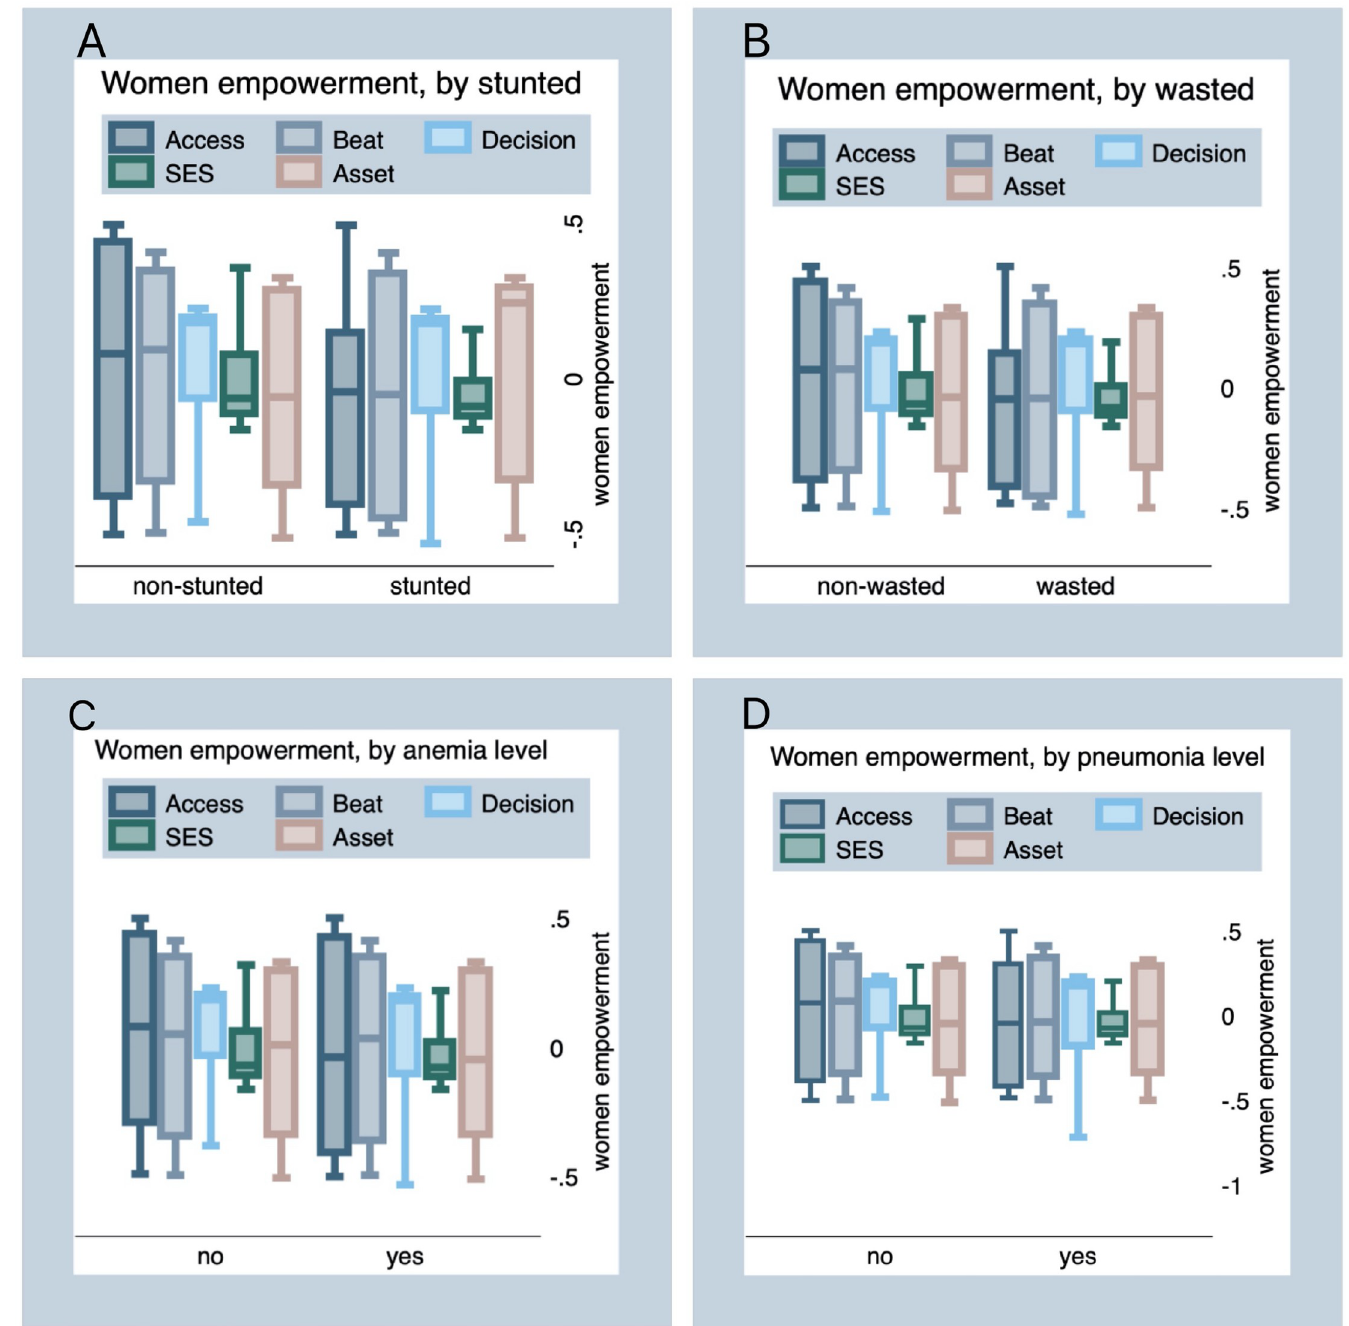
Fig 3. The difference in distribution of the five dimensions of women’s empowerment categorized by child health outcomes. https://doi.org/10.1371/journal.pone.0235825.g003 The test result indicates that the medians of women empowerment components are statisti- cally different between stunted and non-stunted children as well as between wasted and non- wasted children (Pr = 0.000), except, for asset ownership, for which we do not observe a signif- icant difference between wasted and non-wasted children (Pr = 0.718). We observe significant